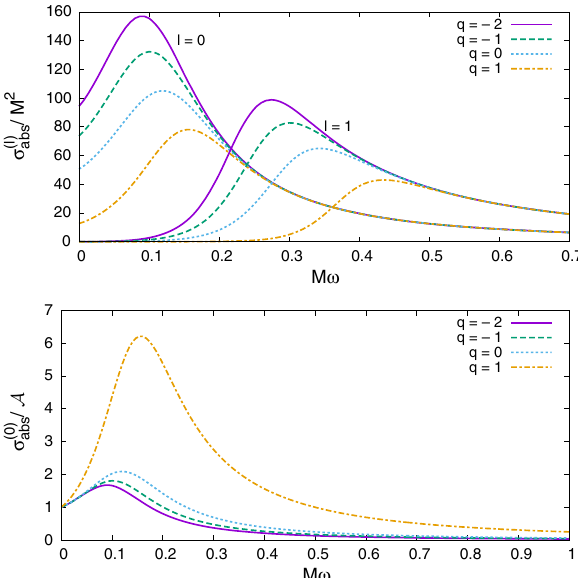
Fig. 4 Partial absorption cross sections in units of the black hole mass squared for l = 0 , 1 (top) and in units of the black hole area for l = 0 (bottom)